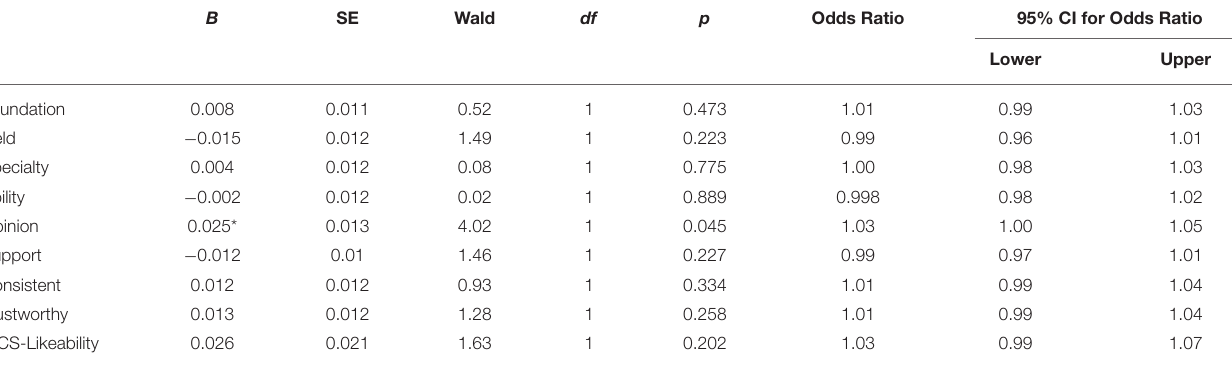
TABLE 11 | Logistic regression predicting sentencing decision from continuous expert persuasion expectancy (ExPEx) ratings and witness credibility score (WCS) for